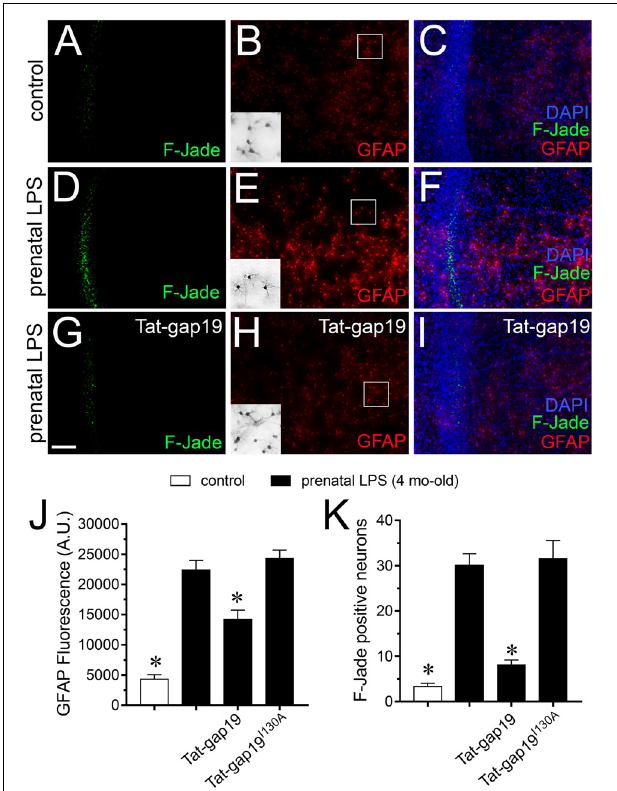
FIGURE 8 | Cx43 hemichannel contributes to neuronal death evoked by prenatal LPS exposure on offspring hippocampus. (A–I) Representative images depicting Fluoro-Jade (F-Jade, green), GFAP (red) and DAPI (blue) staining in acute slices from control offspring (A–C) or prenatally LPS-exposed offspring of 4 months old alone (D–F) or in combination with the in vivo administration of 23 mg/kg Tat-gap19 (G–I) . Insets of gray scale GFAP staining for astrocytes are shown from the area depicted within the white squares in (B,E,H) . (J) Averaged data of GFAP fluorescence per field in acute slices from control offspring (white bars) or prenatally LPS-exposed offspring of 4 months old alone (black bars) or in combination with the in vivo administration of 23 mg/kg Tat-gap19 (gray bars). ∗ p < 0.01 versus LPS, one-way ANOVA Tukey’s post hoc test, mean ± S.E.M., n = 3. (K) Averaged number of F-Jade-positive CA1 pyramidal neurons per field in acute slices from control offspring (white bars) or prenatally LPS-exposed offspring of 4 months old alone (black bars) or in combination with the in vivo administration of 23 mg/kg Tat-gap19 (gray bars). ∗ p < 0.001 versus LPS, one-way ANOVA Tukey’s post hoc test, mean ± S.E.M., n = 3. Calibration bar = 100 µ